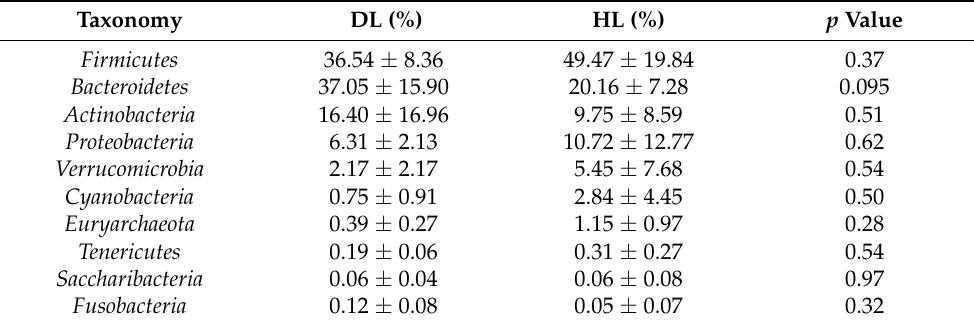
Table 2. Comparison of top 10 phyla in the feces of kids suffering diarrhea (DL, n = 3) and healthy